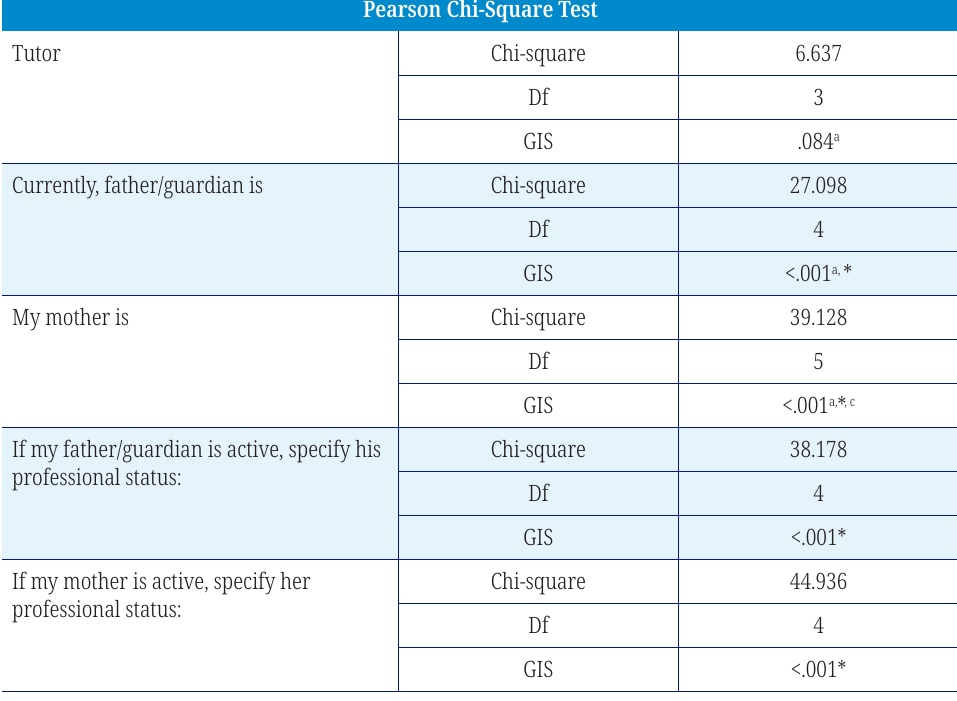
Table 6. Pearson chi-square test: activity status and professional status of parents of public/private university